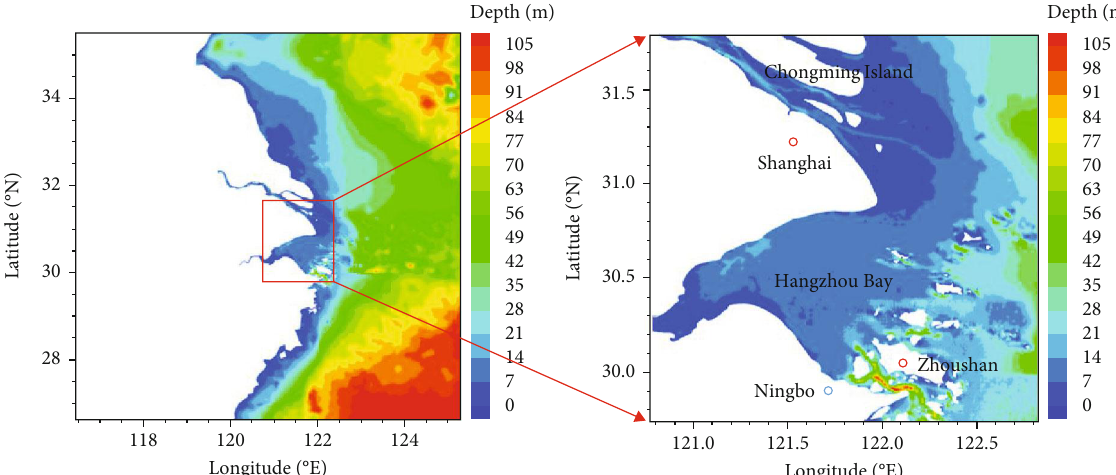
Figure 1: Location of the study area and the geographic location of Ningbo – Zhoushan Port Main Corridor.